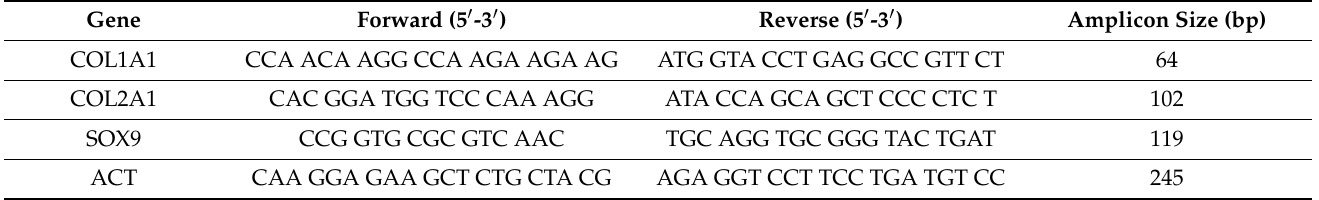
Table 1. Primer sequences used in Real-Time PCR showing the forward and reverse sequences of the chosen primers, with the resulting amplicon